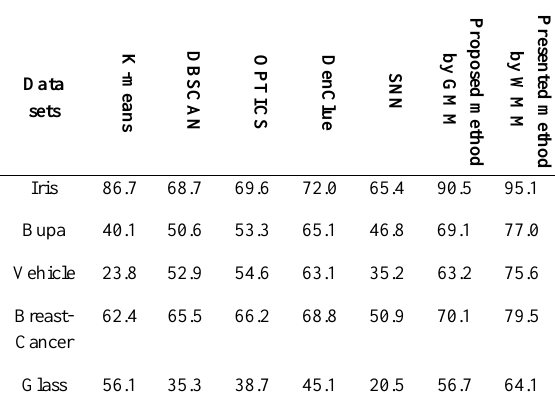
Table 2. Clustering accuracies (in %) of compared clustering methods on selected UCI datasets.